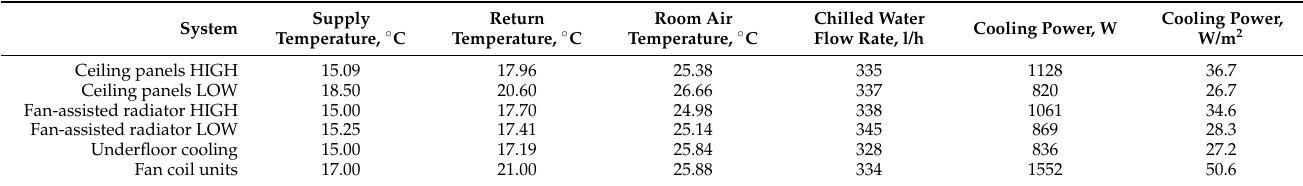
Table 5. Test conditions, 1-hour values.